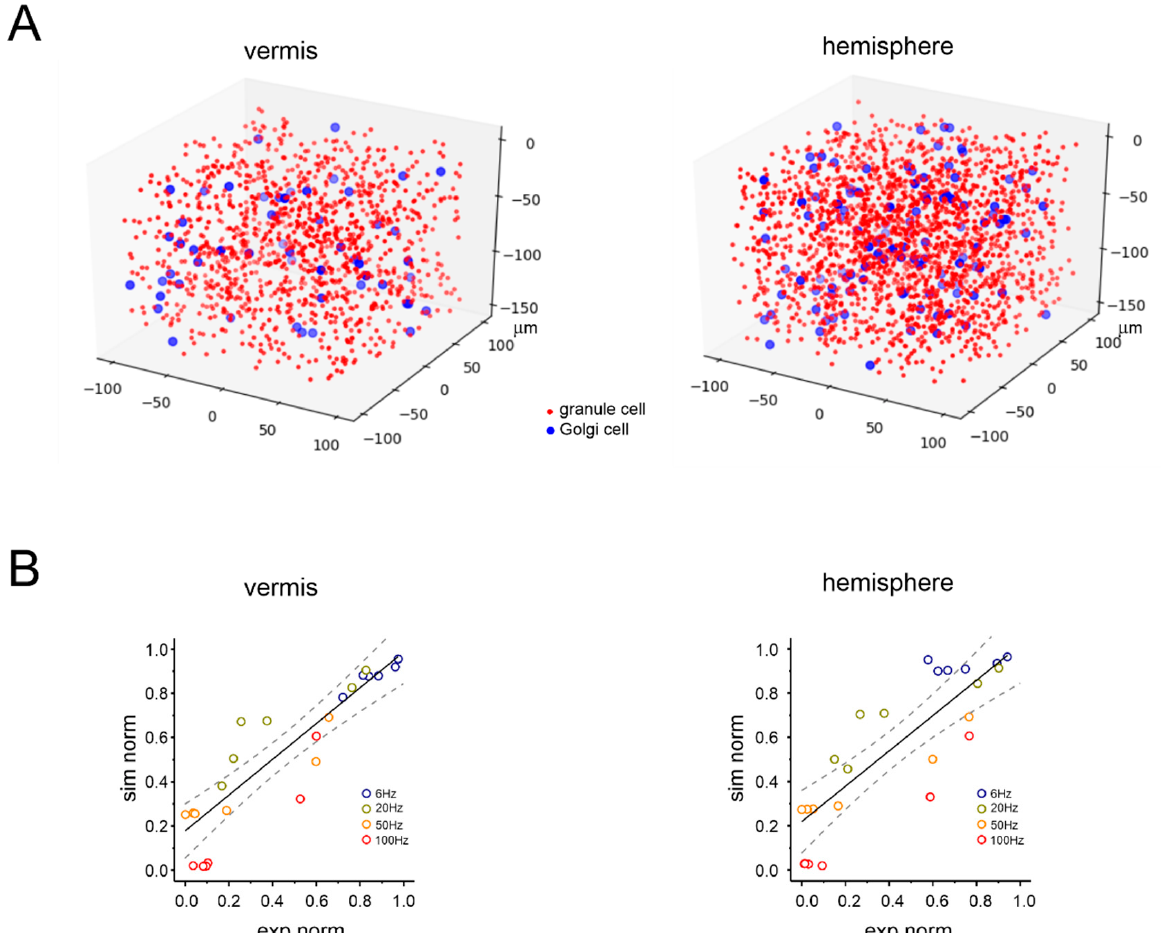
Figure 5. Realistic computational modeling of granular layer response in the vermis and hemisphere. ( A ) Schematic illustration of the spatial distribution of granule cells (red dots) and Golgi cells (blue dots) in a volume chunk of the granular layer (100 μ m 3 ) of the cerebellar vermis and hemisphere in a realistic computational model derived from 45. For better rendering, granule cells are down-sampled by a factor of 20. There are 1203 granule cells and 55 Golgi cells for the vermis, 1980 granule cells and 113 Golgi cells for the hemisphere. ( B ) Computational model validation against the experimental data for the vermis and hemisphere. The plot shows the distribution of normalized response amplitude experiments (N 2a peak amplitude) and simulations using the same stimulation frequency. The time points considered for model validation are 1, 2, 10, 20, 25, and 35 s. The simulated frequencies are the same as those used in the experiments. The black lines are linear fittings (vermis: slope 0.81, R 2 0.73, p < 0.001; hemisphere: slope 0.80; R 2 0.70, p < 0.001), the dashed lines are 95% confidence